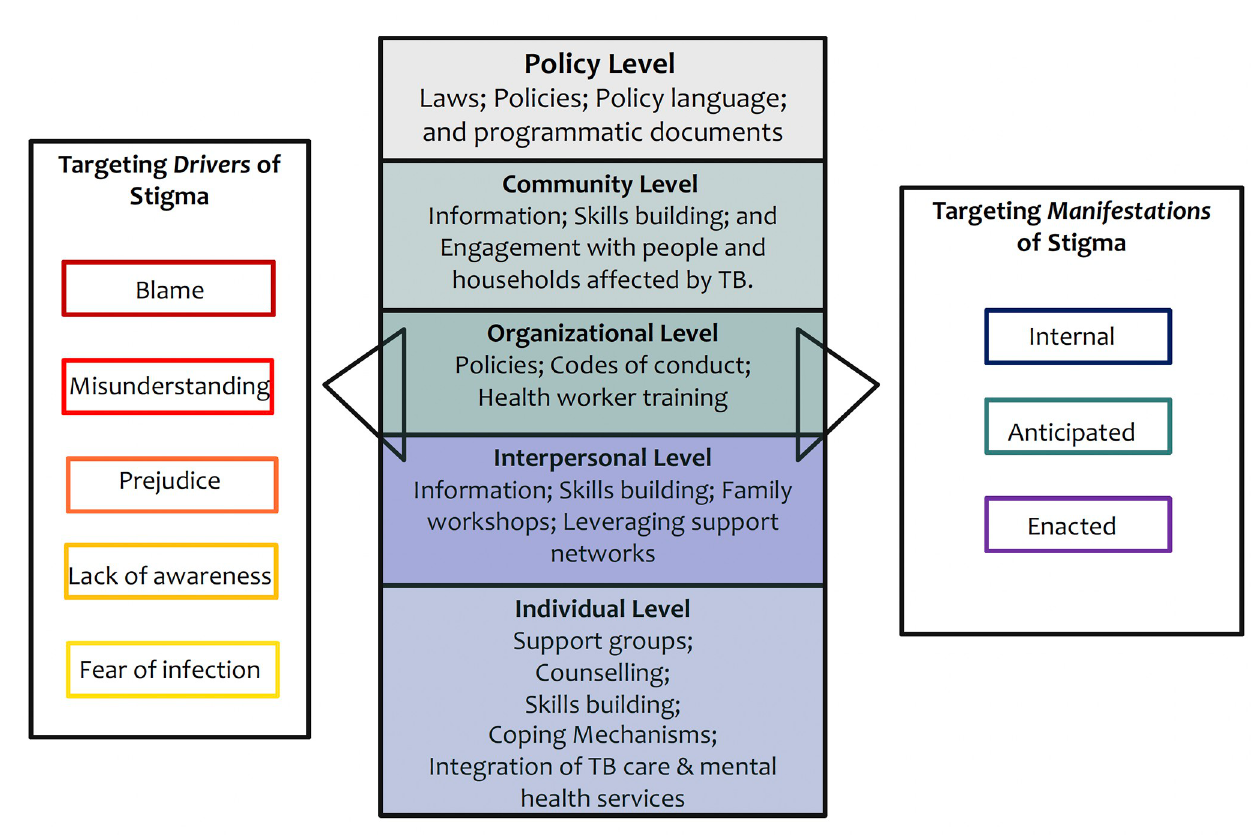
Fig 2. Potential stigma reduction interventions targeting stigma drivers and/or manifestations that could be implemented at different socio-ecological